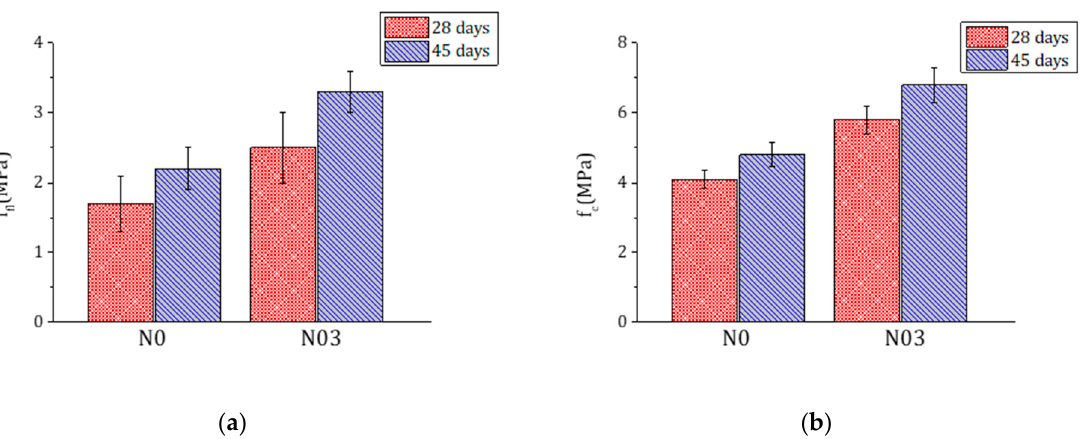
Figure 11. Flexural strength f fl ( a ) and compression strength f c ( b ) of samples with 0% FC (N0) and 0.3% FC (N03) at 28 d (red) and 45 d (blue). Table 3. Flexural strength (f fl ) of samples with 0% FC (N0) and 0.3% FC (N03).